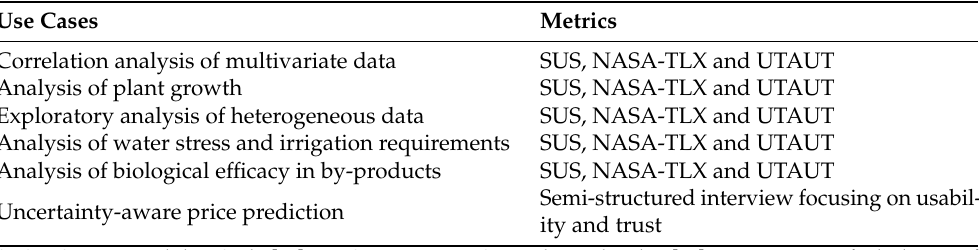
Table 1. Use cases and respective evaluation